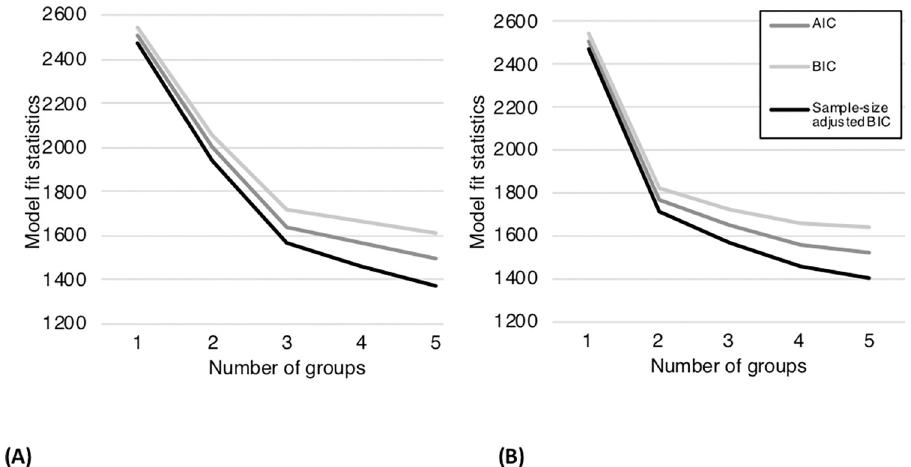
Fig 5. Model fit statistics for 1–5 group solutions for AP-P showing (a) AP-P chroma accuracy and (b) AP-P chroma accuracy ST.